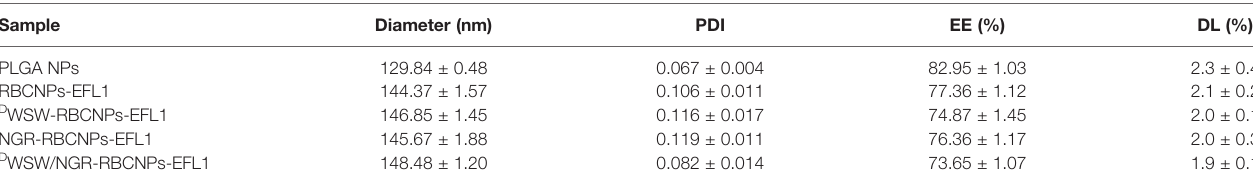
Data are represented as mean ± SD, n =